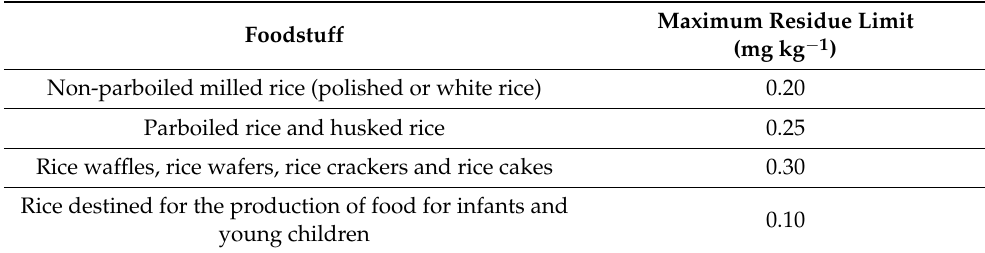
Table 1. Maximum residue limits (MRLs) for arsenic (inorganic) in rice and rice products (Regulation